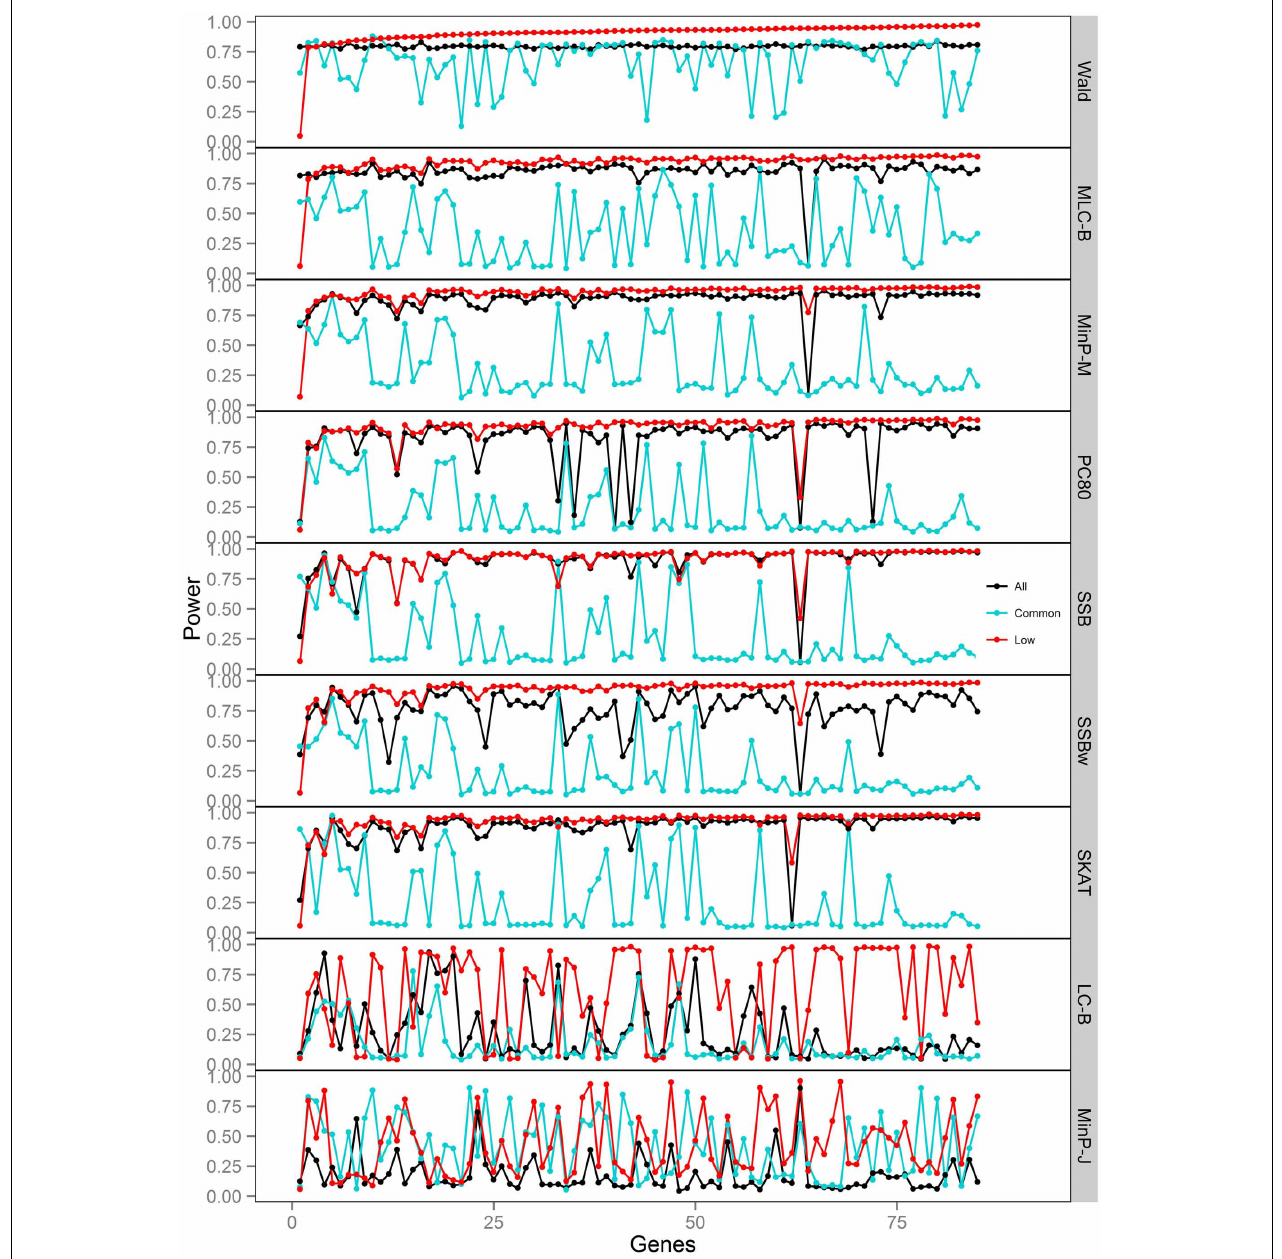
FIGURE 3 | Power of gene-based tests using three analysis sets of SNPs for 85 genes under trait Model 1 . Genes are ordered along the horizontal axis according to the empirical power of Wald test using only low frequency